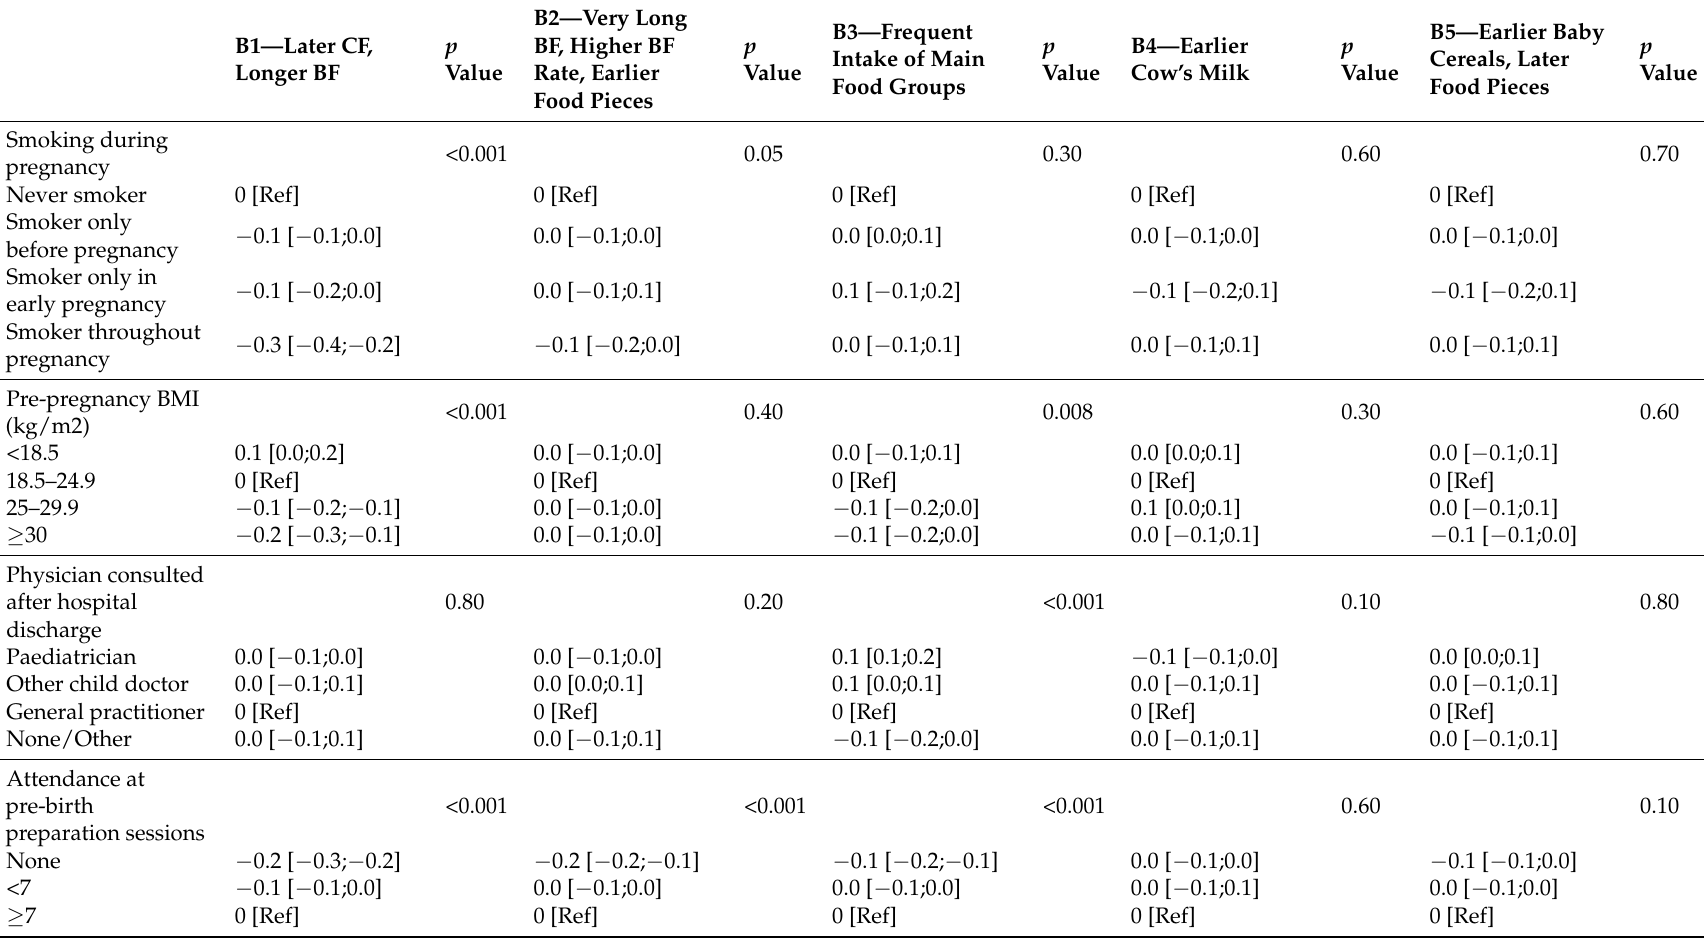
Table 5. Multivariable linear regression analysis explaining each pattern (identified by principal component analysis (PCA)) by family characteristics (not shown) and health-related variables ( n =